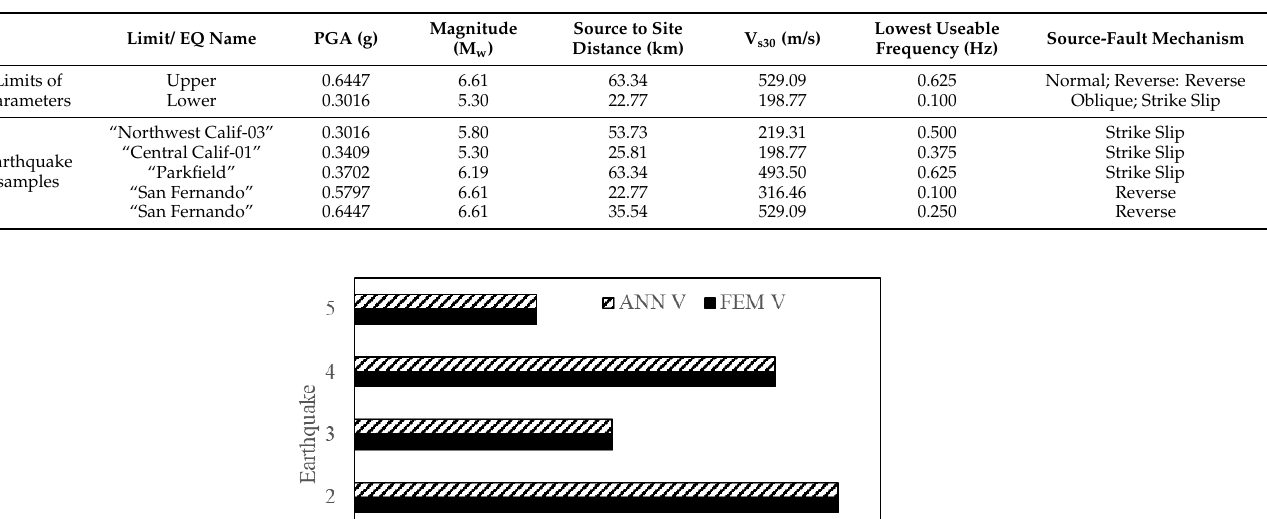
Table 3. Characteristics EQs used to test a four-story building.